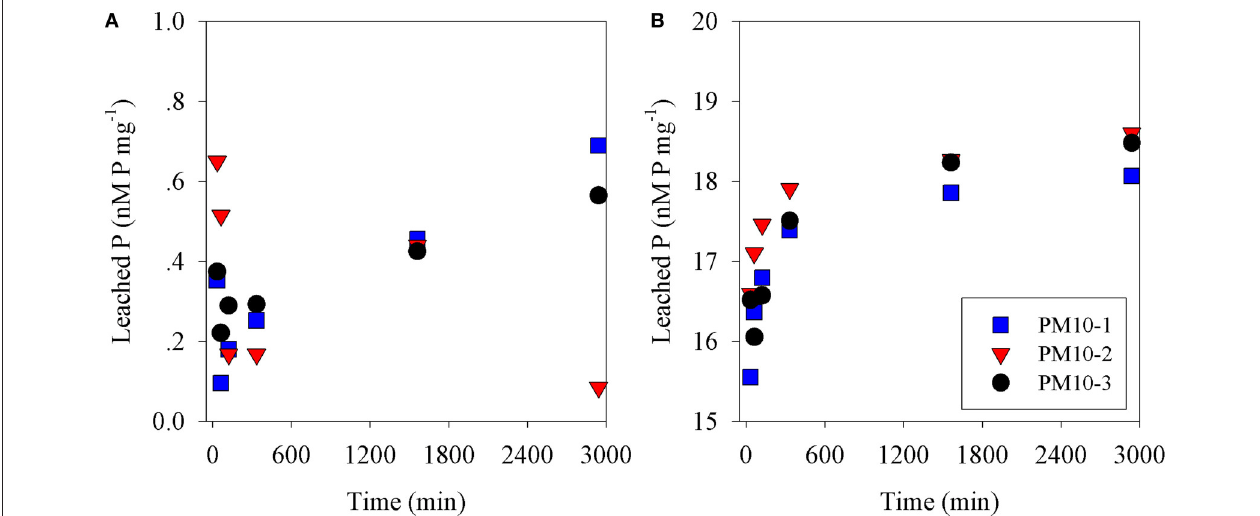
FIGURE 1 | Phosphate leached from (A) PM10 (three replicates) vs. time into seawater and (B) PM10 leached into seawater acidified to pH = 2 (three replicates) expressed as nM phosphate mg dust − 1 .